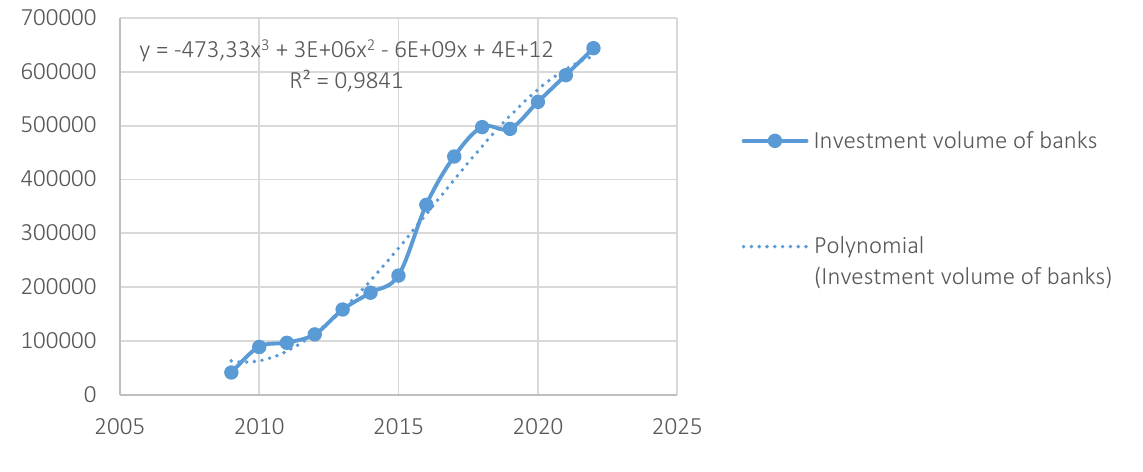
Figure 1. Trend model of investment volume of Ukrainian